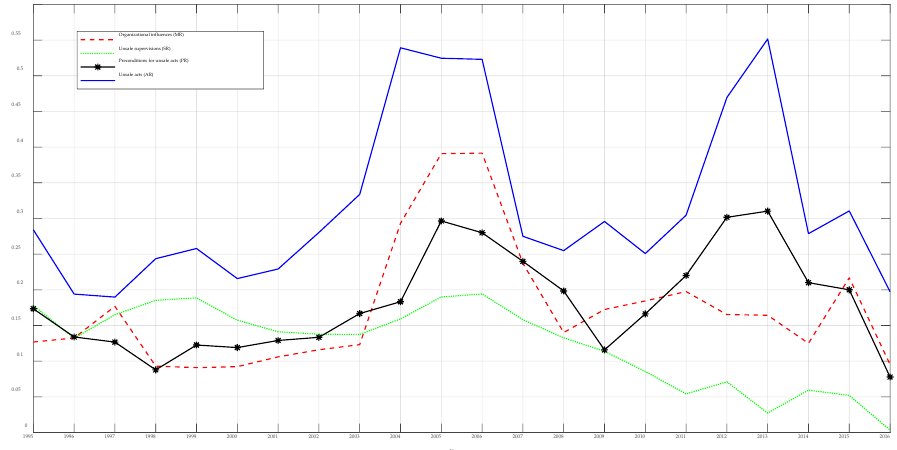
Figure 7. HOF risk level of HFACS from 1995 to 2016.